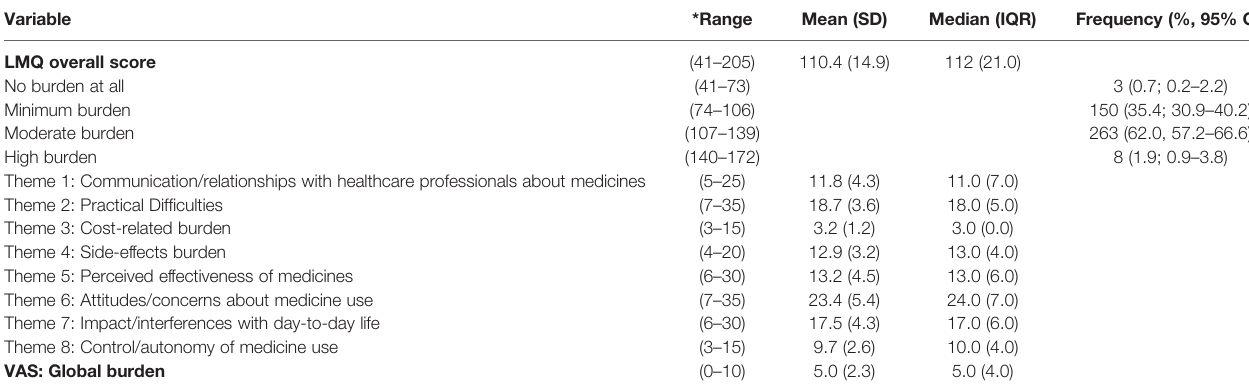
TABLE 4 | Perceived medication-related burden measured using Living with Medicines Questionnaire version-3 (LMQ-3) and VAS (n=424).